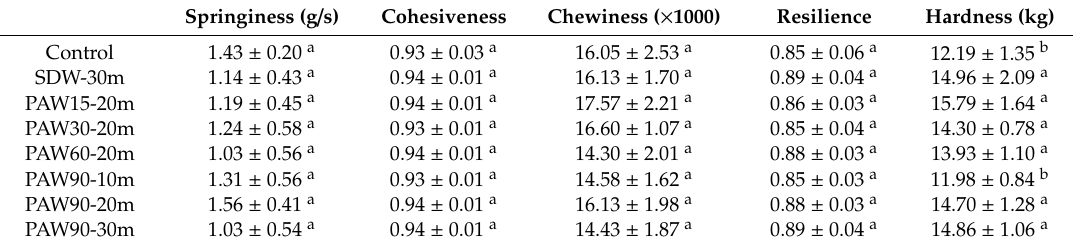
Table 2. Influence of plasma-activated water treatment on the textural properties of thin sheets of bean curd.